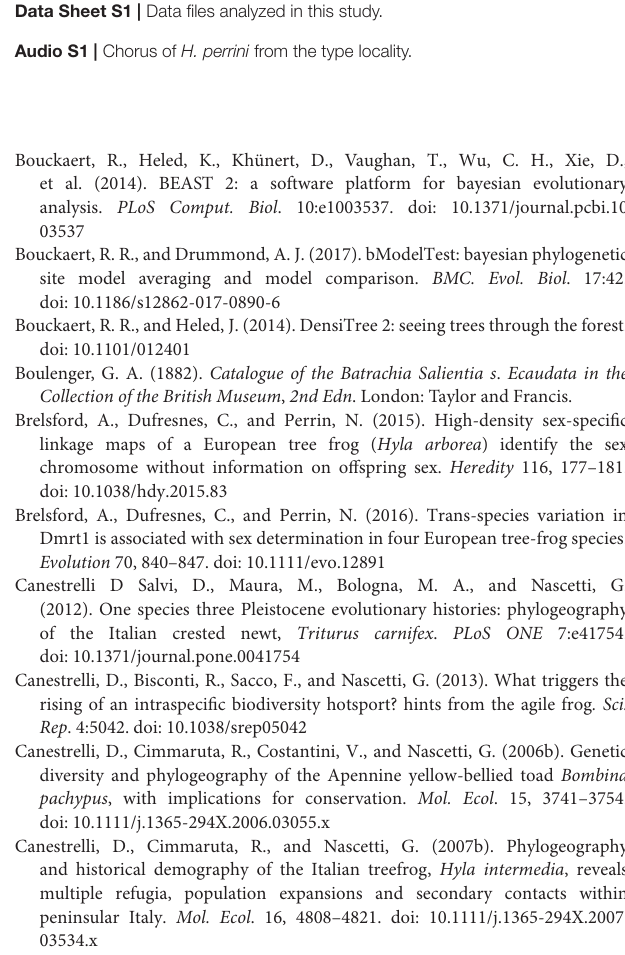
Figure S1 | Localities used in the niche modeling analyses. Figure S2 | PCA on the phylogenomic dataset. Figure S3 | Distribution of morphometric data for H. perrini , H. intermedia s. s. and H. arborea. Figure S4 | Distribution of bioacoustic variables for H. perrini , H. intermedia s. s. and H. arborea. Figure S5 | Ventral and dorsal view of the paratypes of H. perrini . Table S1 | Samples included in this study. Table S1A | Sequences included in the mitochondrial phylogeny. Table S1B | Samples included in the nuclear phylogeny. Table S1C | Localities included in the hybrid zone analyses. Table S1D | Populations sampled for the biometric analyses. Table S2 | Variables used in the ecological niche modeling and their contributions. Table S3 | Measurements of the type